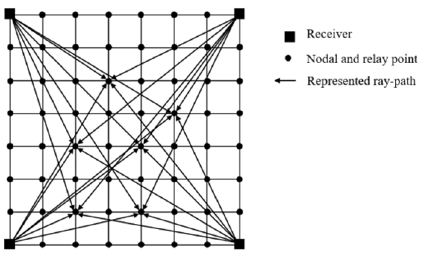
Figure 2. Potential emission time computation.